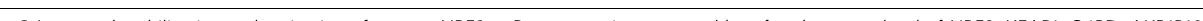
calibration the relative degrees of roGFP1 oxidation and corresponding roGFP1 redox potentials can be calculated. e Baseline redox conditions of NRF2 WT 2 and NRF2 p.T80K fi broblasts. Upper diagram shows the relative level of roGFP1 oxidation of NRF2 WT 2 and NRF2 p.T80K cells at rest (OxD roGFP1 , Eq. 1). Lower diagram represents corresponding steady-state roGFP1 redox potential (E roGFP1 , Eq. 2). b , c Data are given as means ± SEM, n ≥ 3 independent experiments. Data were analyzed by one-way analysis of variance with multiple comparisons: * p ≤ 0.05, ** p ≤ 0.01, *** p ≤ 0.001. e Data are given as means ± SEM. Number of measured cells are given within the bar. Statistical differences were obtained with unpaired Welch ’ s t -test: *** p ≤